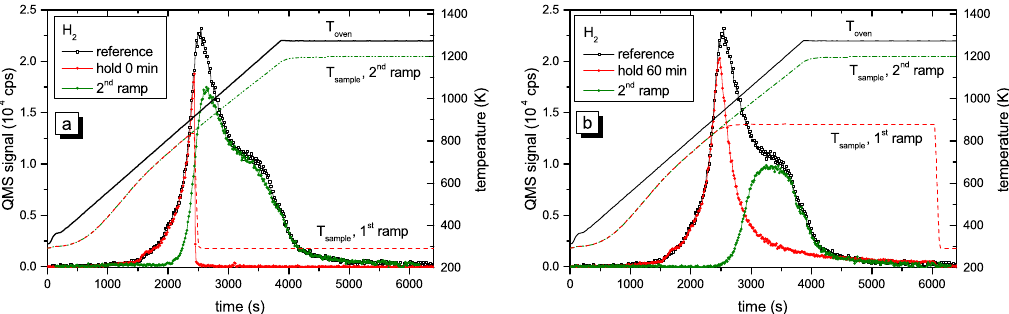
Figure 4. Results from R&H experiments for T hold = 878 K and t hold = ( a ) 0 and ( b ) 60 min (nominal temperature ramp of 15 K/min). The QMS signal after background subtraction is shown on the left-hand scale and the oven and sample temperatures are shown on the right-hand scale. Due to the time lag between oven and sample temperature, the maximum sample temperature for t hold = 60 min is 878 K, i.e., it is 33 K higher than the maximum sample temperature for t hold = 0 min reached at the end of the